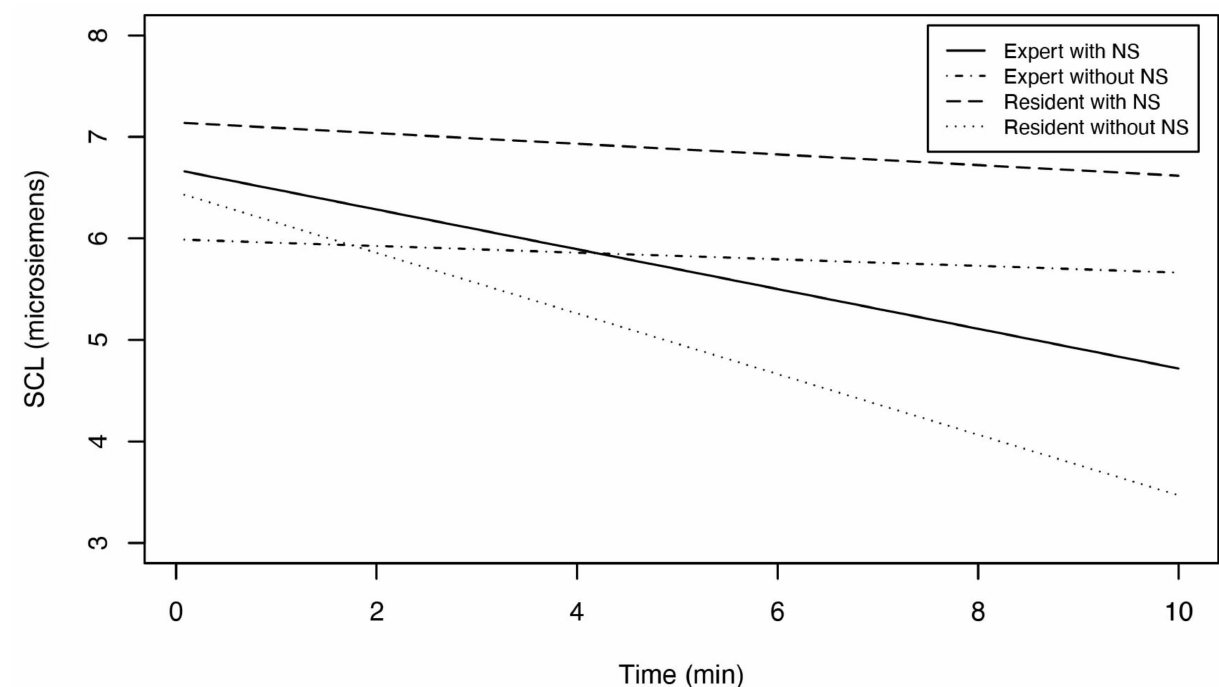
Figure 4. Prediction of the surgeons’ SCLs during the 10-min